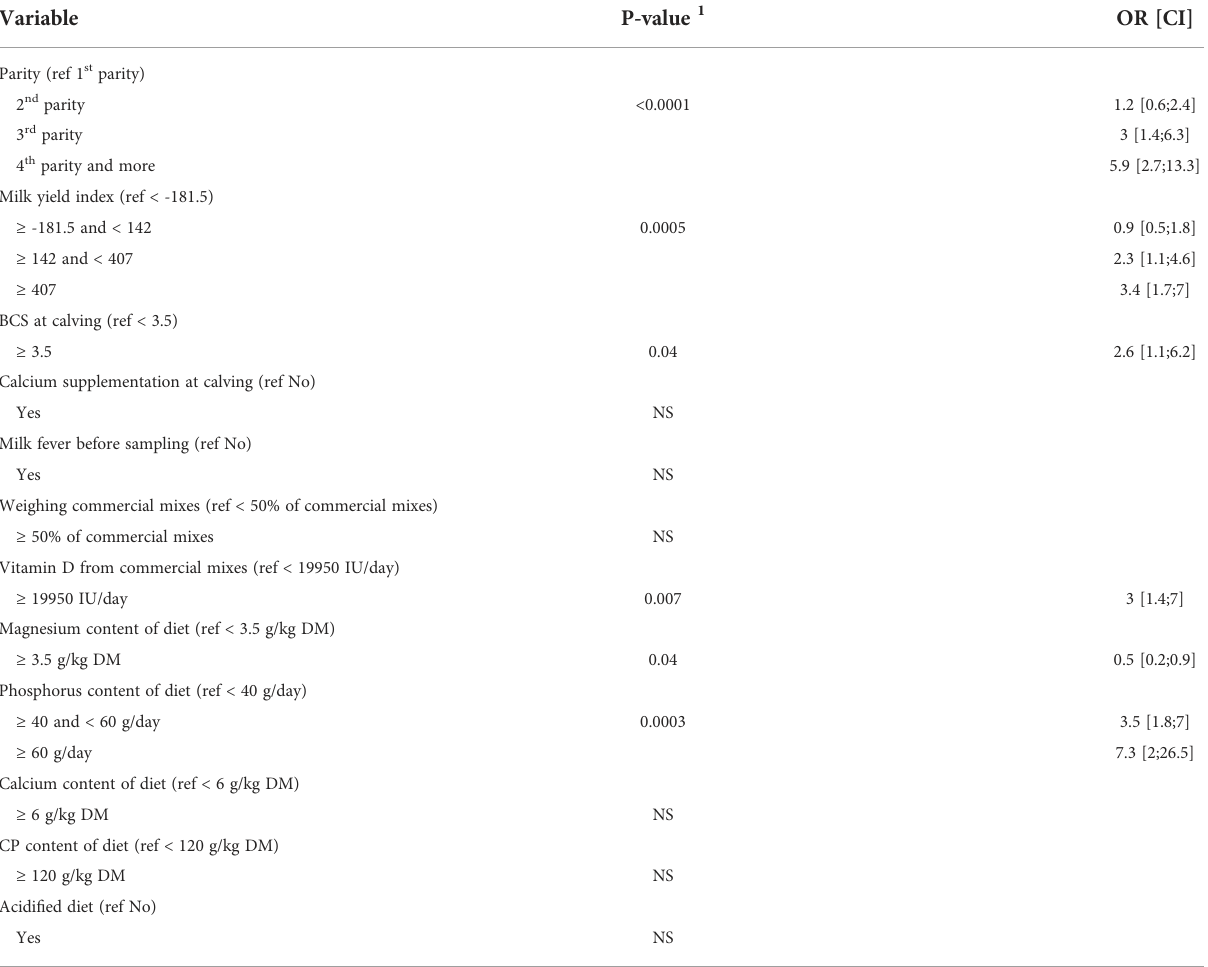
TABLE 6 Results from multivariate model quantifying the effects of parity, milk yield index and feeding practices during dry off on occurrence of subclinical hypocalcemia (SHC), P-values, odds ratios (OR) and associated con fi dence intervals (CI) (n = 371 cows).